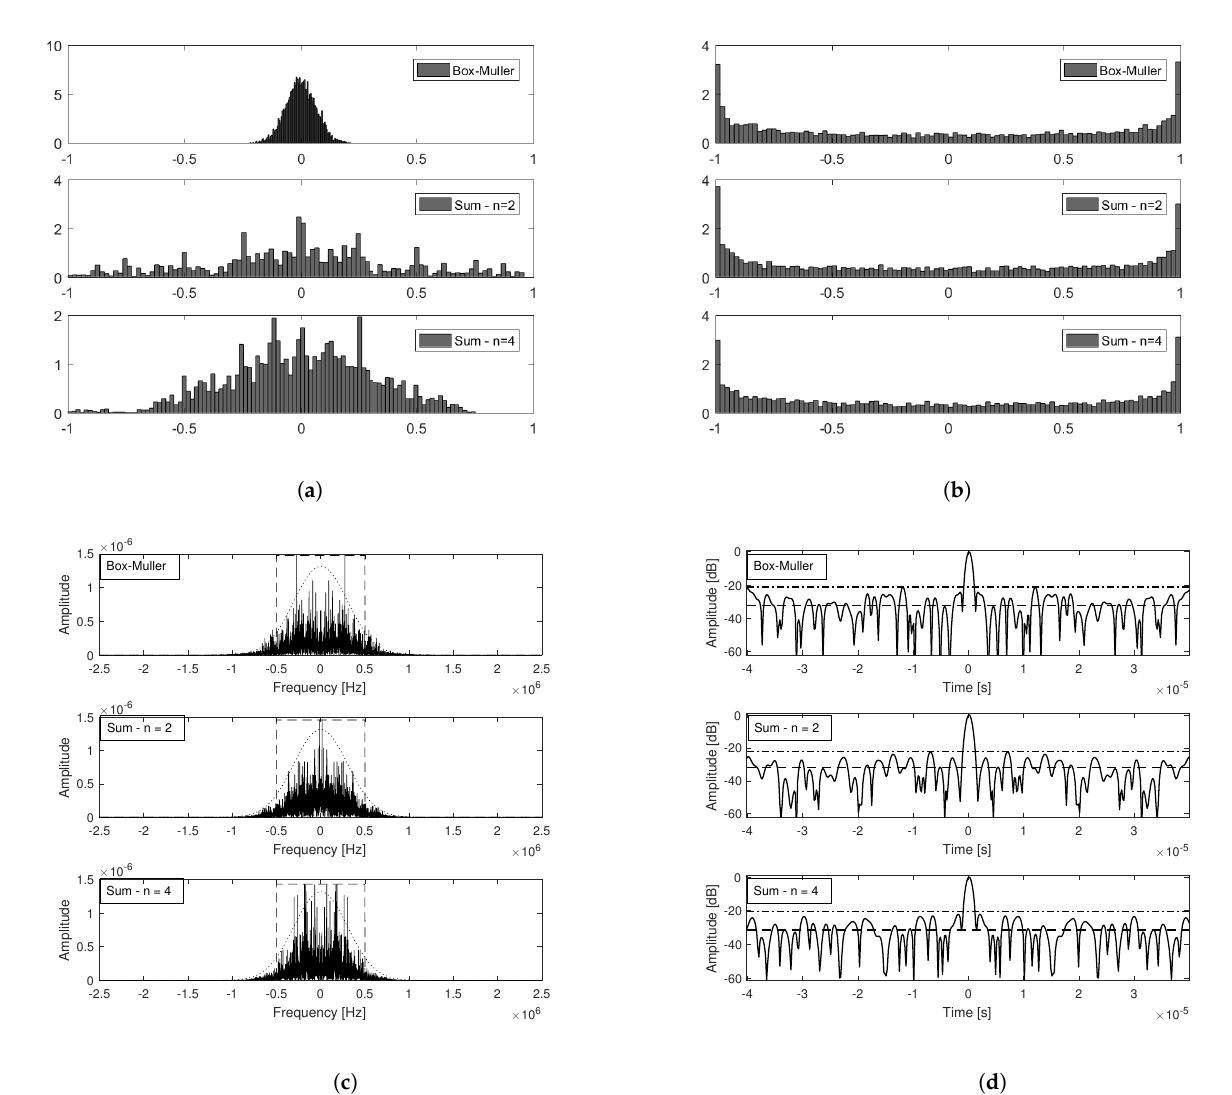
Figure 11. ( a ) Modulating signal’s distributions, ( b ) Transmit signal’s distributions, ( c ) Power Spectral Densities and ( d ) FM Noise pseudo-random waveforms matched filter output (ISL in dashed line and PSL in dot dashed line). Table 1. FPGA implementation—consumed